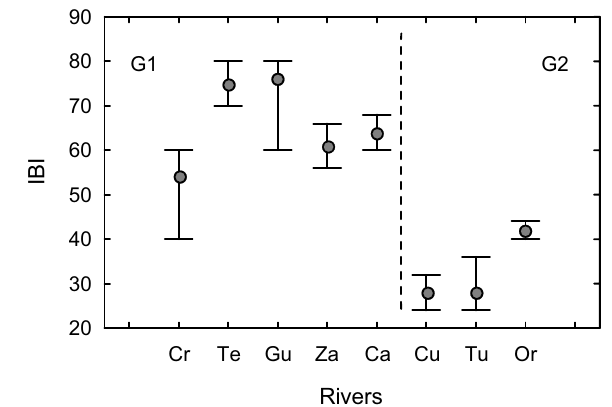
Fig. 2. Mean values and standard deviation of the index of biotic integrity for the tributaries of Sierra de Aroa. The dashed vertical line divides protected (G1) and unprotected rivers (G2). The rivers are organized by their geographical location (East to West). The rivers are: Crucito (Cr), Tesorero (Te), Guarataro (Gu), Zamuro (Za), Carabobo (Ca), Cumaragua (Cu), Tupe (Tu) and Oro (Or). The differences between groups were significantly (Kruskall-Wallis = 16.19, P < 0.0001)